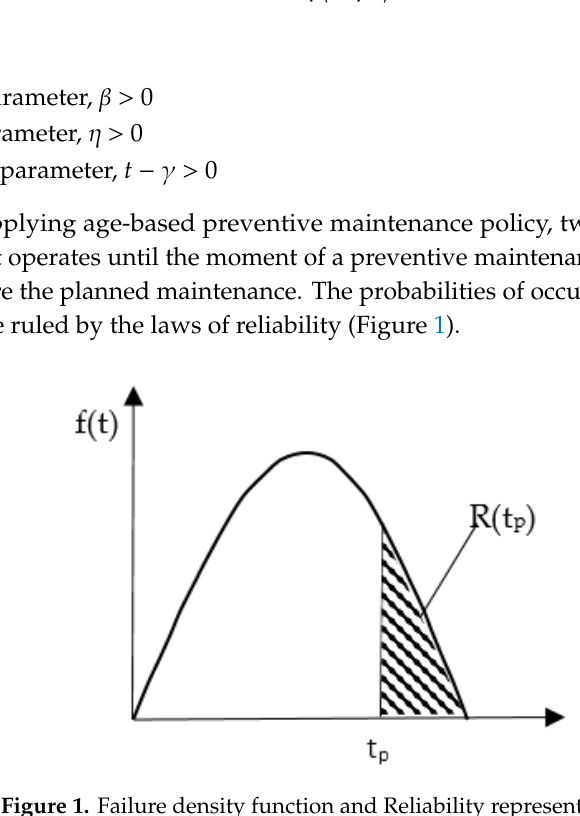
Figure 1. Failure density function and Reliability representation.